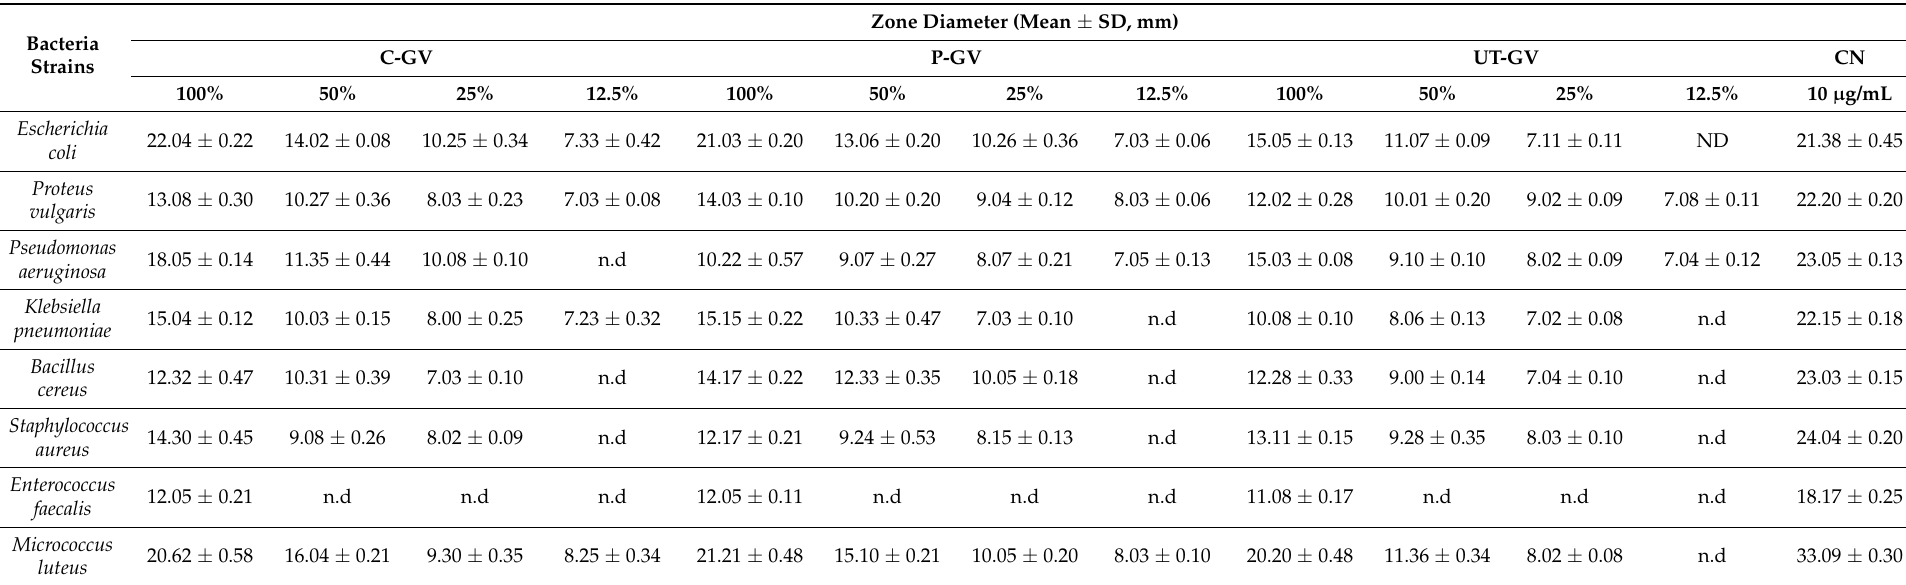
Table 7. Inhibition zones of C-GV, P-GV, and UT-GV in